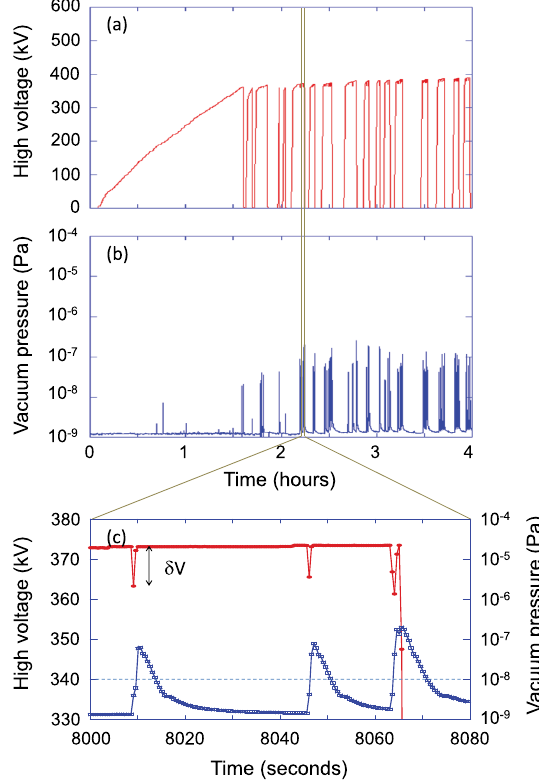
FIG. 5. (a) High voltage and (b) vacuum pressure as a function of time for the first 4 h of HV conditioning result shown in Fig. 4. (c) Enlargement from 8000 to 8080 sec to show how the high voltage drops and the vacuum pressure increases upon prebreak- down event. Data were taken every 0.5